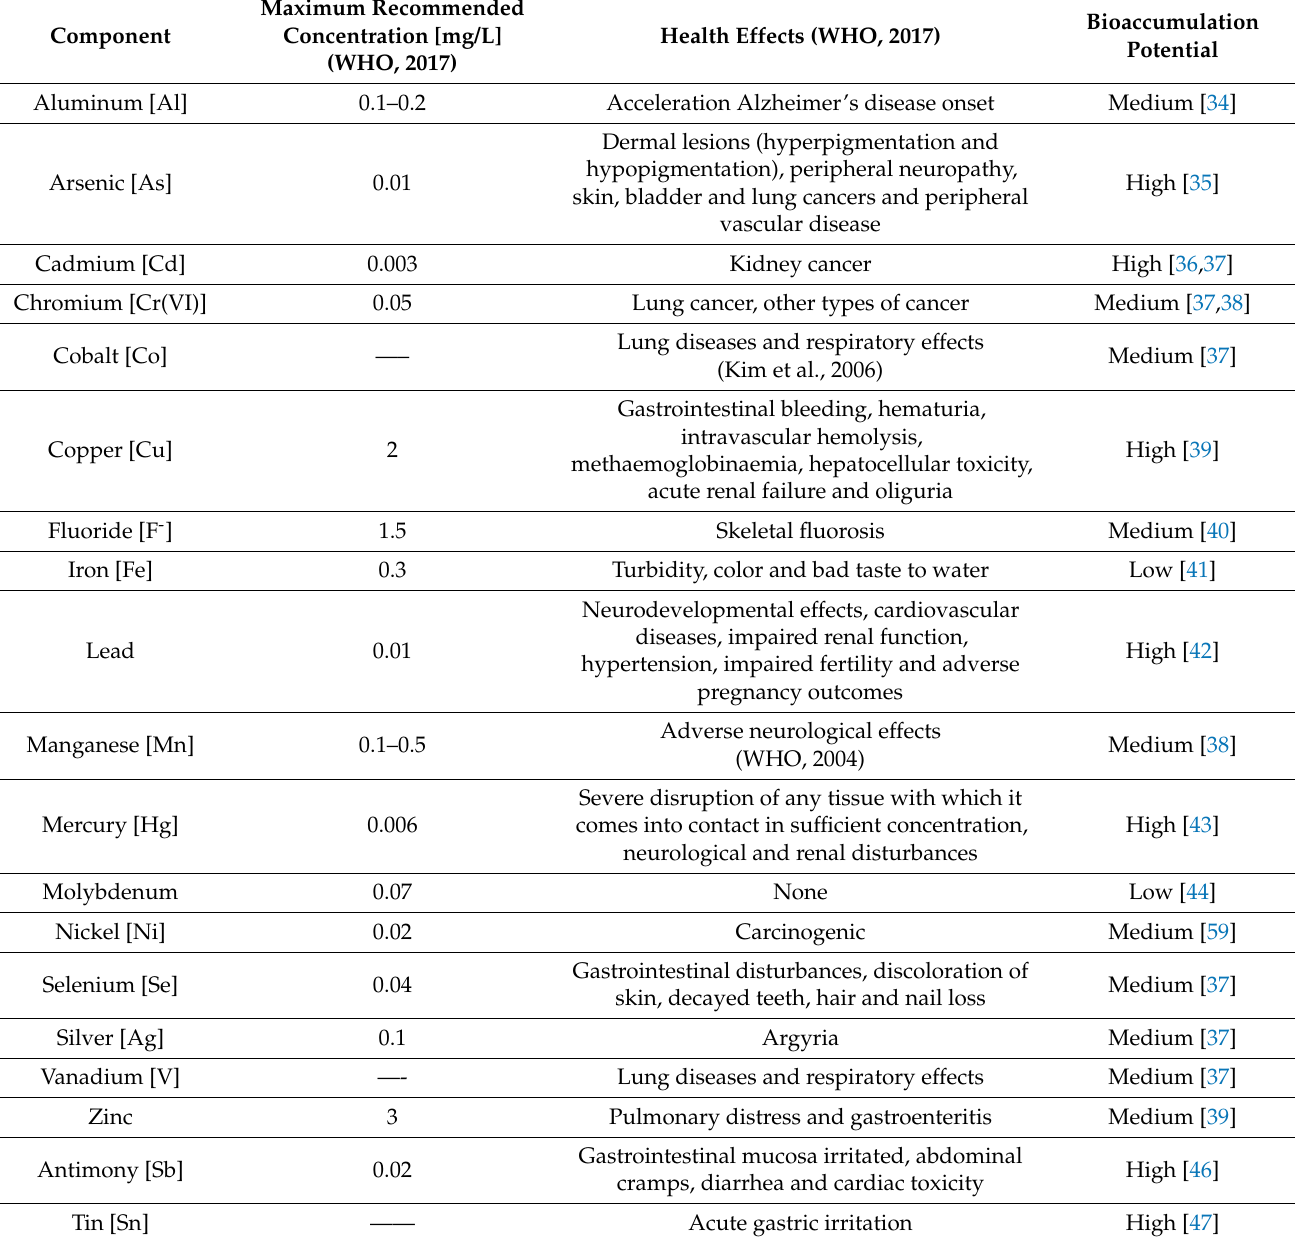
Table 2. Potential health effects of the studied elements, maximum recommended concentration by the WHO [73] and potential for